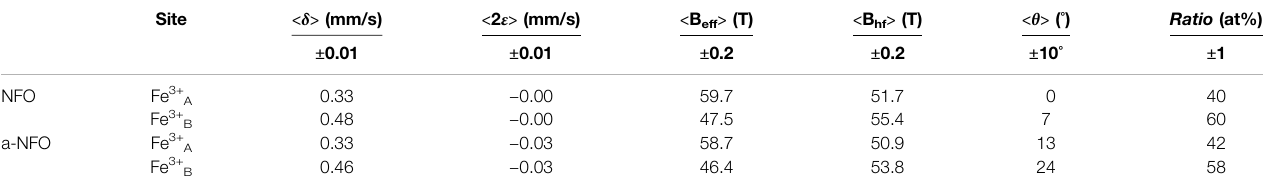
TABLE 2 | The isomer shift ( δ ), the quadrupole shift (2 ε ), the effective fi eld (B eff ), the hyper fi ne fi eld (B hf ), the average canting angle ( ϑ ), and the ratio of each component evaluated from in- fi eld Mössbauer fi tted spectra are reported for NFO and a-NFO.